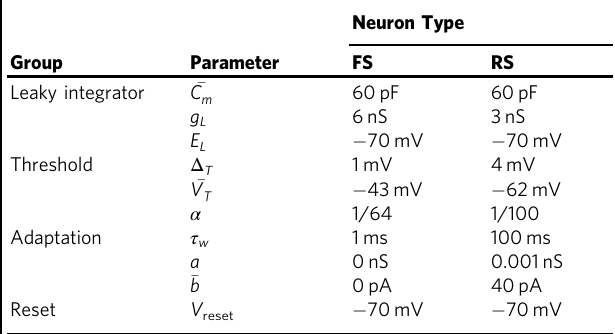
Table 1 Table of parameters used to model fast-spiking (FS) and regular-spiking (RS) interneurons using adaptive exponential-integrate-and- fi re